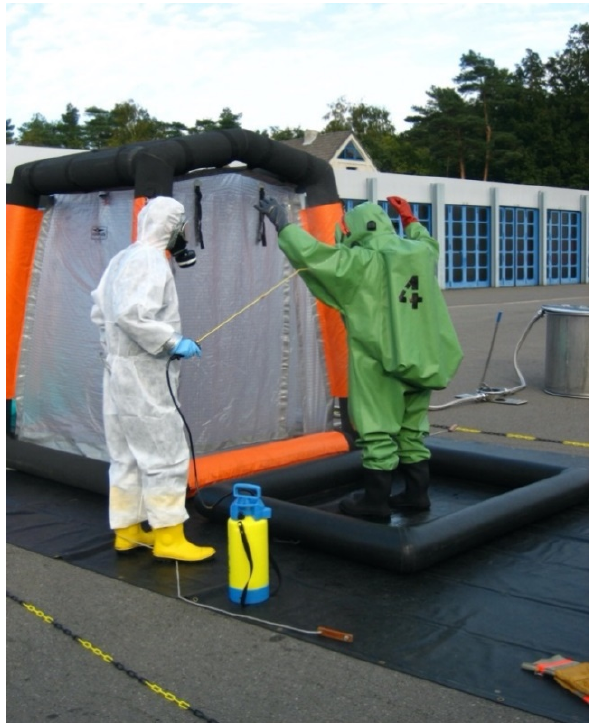
Figure 1. Example of disinfection with mechanical nebulizer (for gentle concession ph. Magnus Mertens) CC BY-SA 2.0 de.